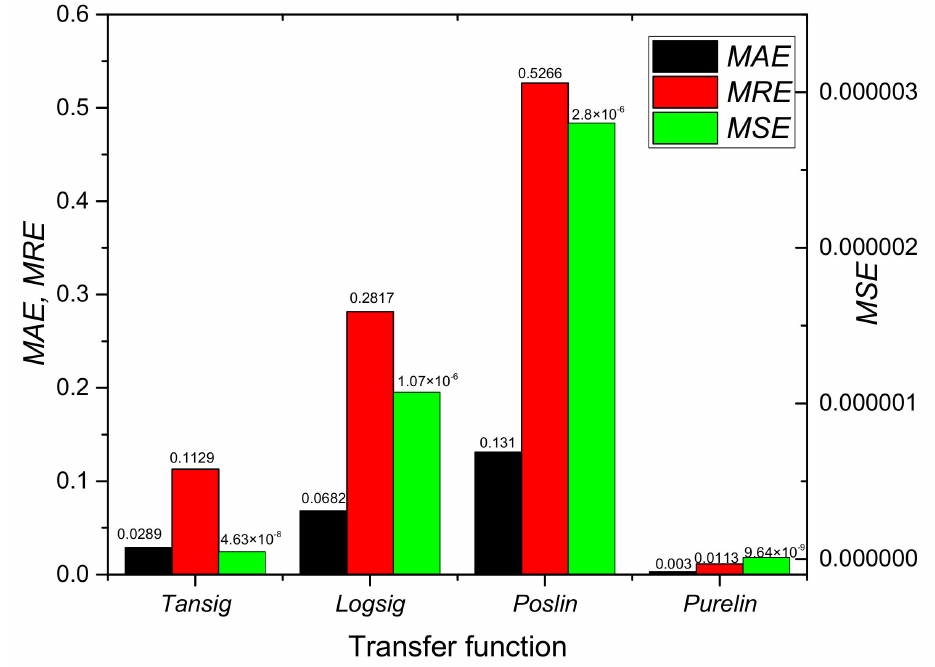
Figure 6. The MAE , MRE , MSE of different transfer functions in the hidden layer. Table 11. Parameters of ANN